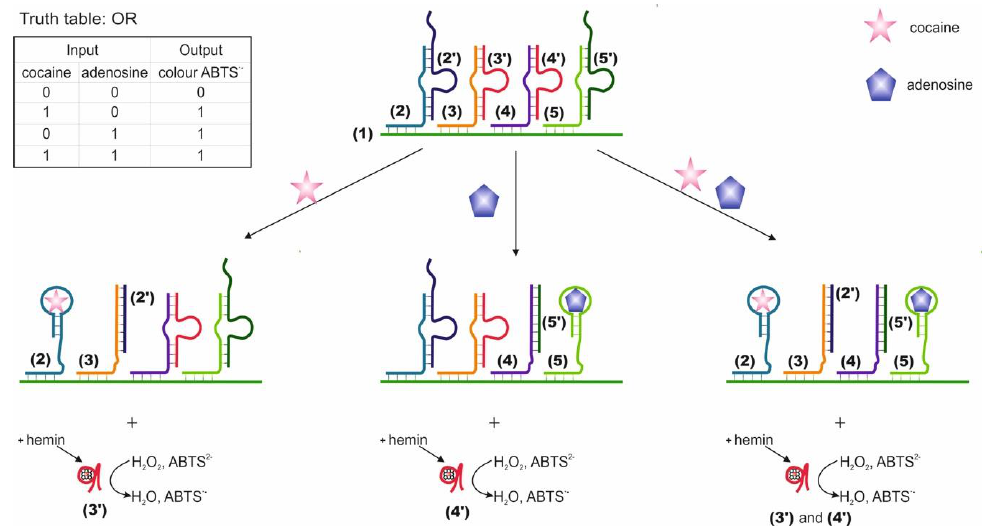
Figure 2. Logic gate OR. ABTS = (2,2-azino-bis (3-ethylbenzothiazoline-6-sulfonic acid) disodium salt). Adapted from Reference [58]. Copyright © 2020, American Chemical Society.